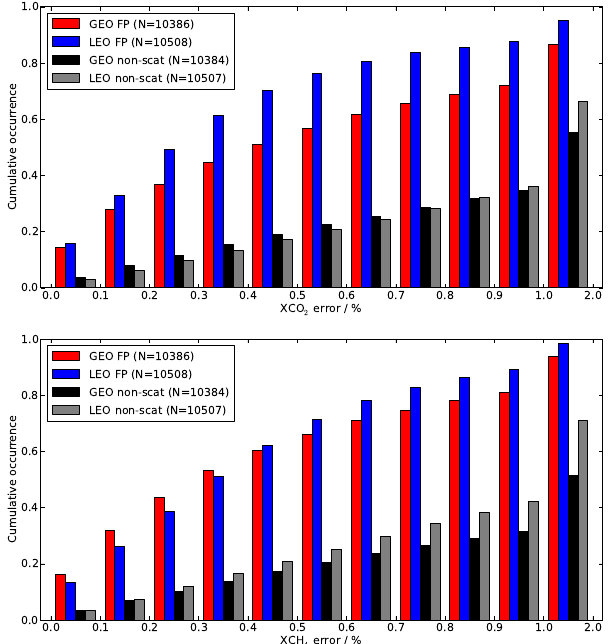
Figure 12. Cumulative relative occurrence of XCO 2 (upper) and XCH 4 (lower) errors for the full-physics (FP) and non-scattering (non-scat) retrievals mimicking a LEO or a GEO satellite as in- dicated by the legend. Number N of successful retrievals as in- dicated by the legend. Only non-scattering retrievals that pass the corresponding full-physics retrievals are counted. Full-physics quality filters screen non-convergent behavior, ocean surfaces, VZA > 70 ◦ , SZA > 70 ◦ , and SNR-limited dark scenes in SWIR-3 (albedo × cos(SZA) /π < 0 .